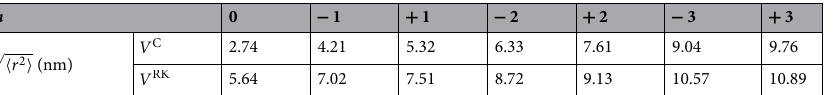
m , 0, m , 0, 0 0 and as obtained | ; + +; � | ; − −; − � 6 and ε d 28 . In the case of the Coulomb = =